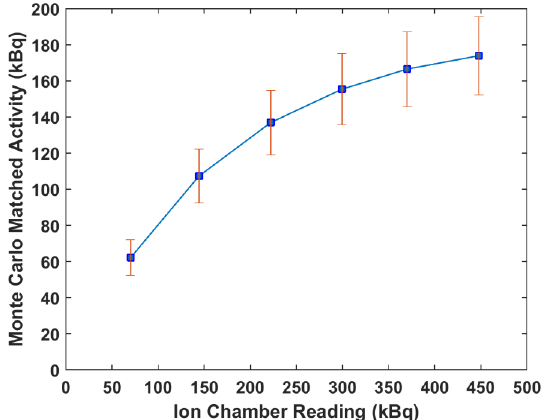
Figure 8. Activity response relationship between ion chamber reading and Monte Carlo-NaI(Tl) corrected spectra activity.